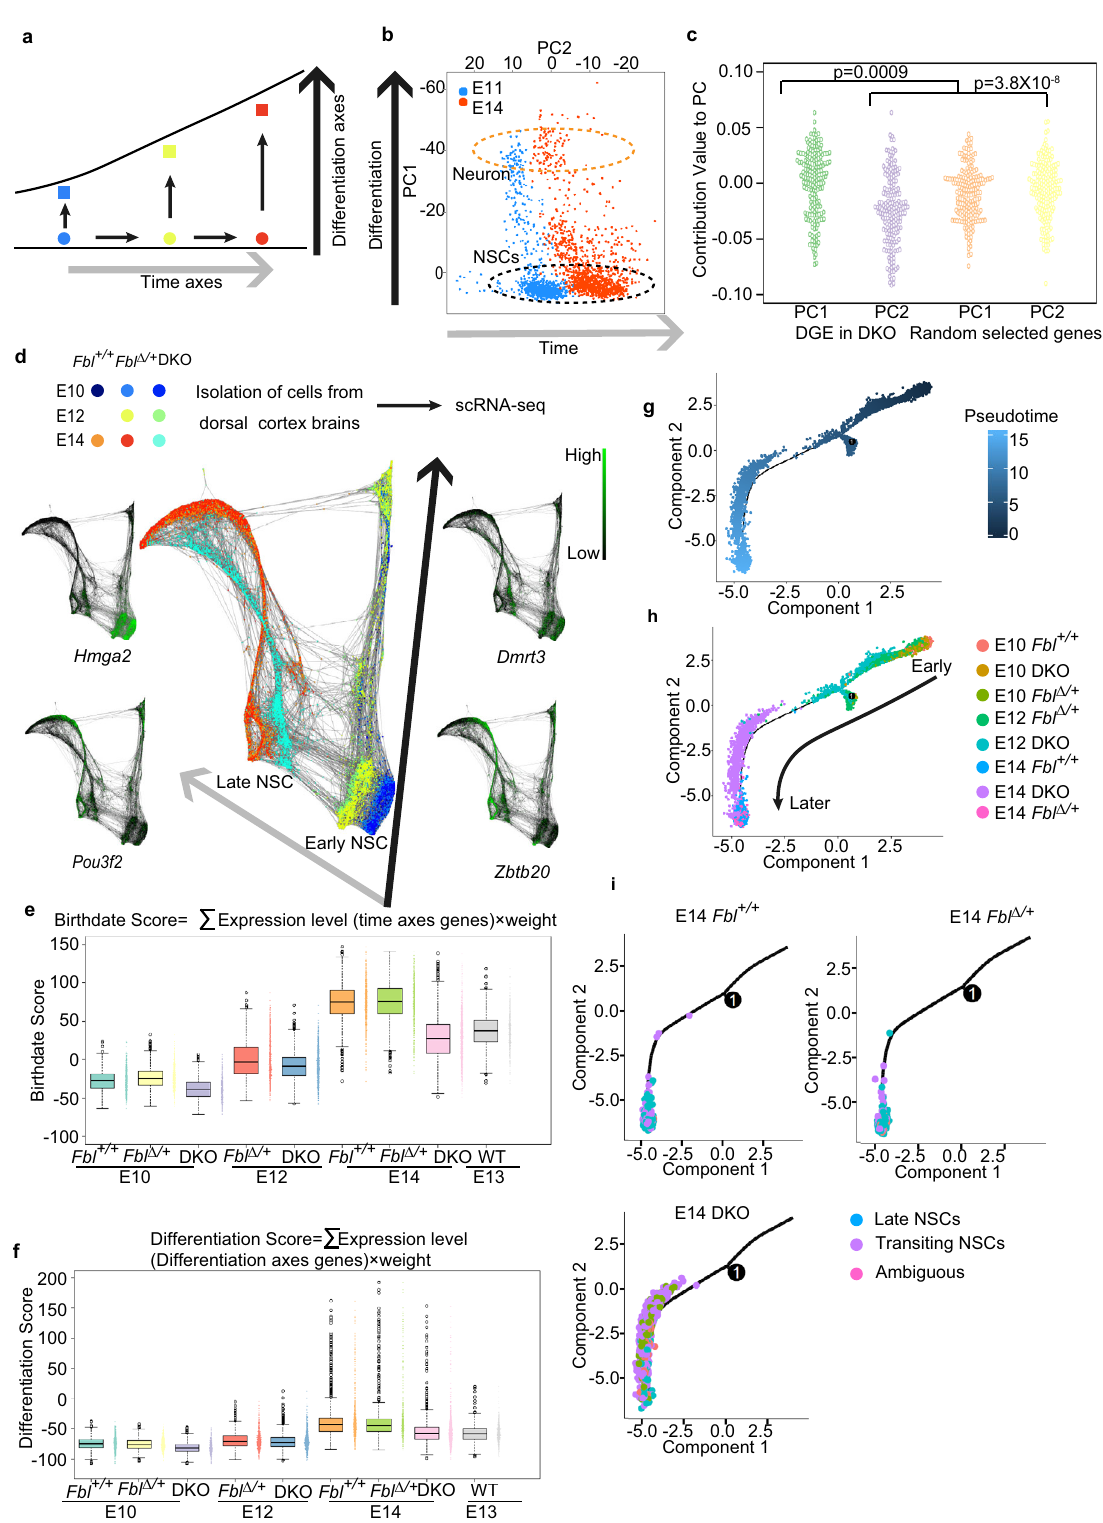
with SPRING 19 (Supplementary Fig. 5c). Therefore, cells were deposited along the differentiation and temporal axes. Consistent with the t-SNE analysis, DKO cells from E10 and E12 could not be distinguished from controls at the same stages. In contrast, E14 DKO cells were plotted between E12 Fbl Δ / + and E14 Fbl + / + or Fbl Δ / + cells, implying delayed temporal identity transition (Fig. 2d).